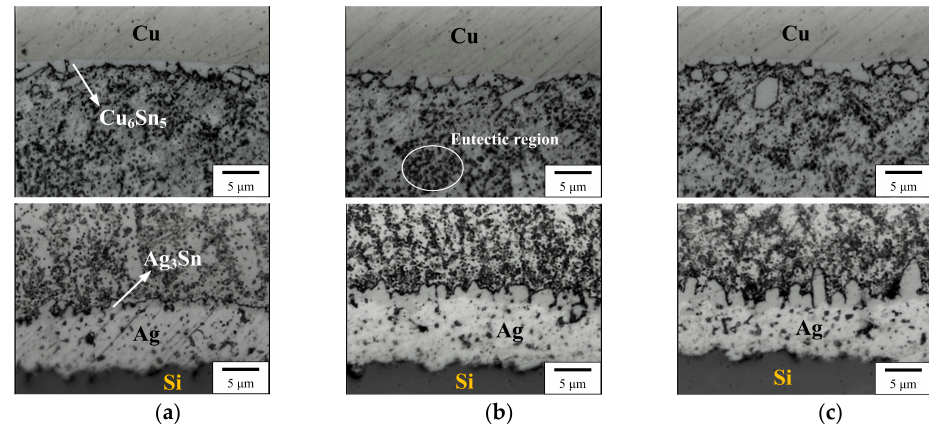
Figure 1. Interfacial images of the structure of a Sn–0.7Cu–0.2Zn photovoltaic (PV)